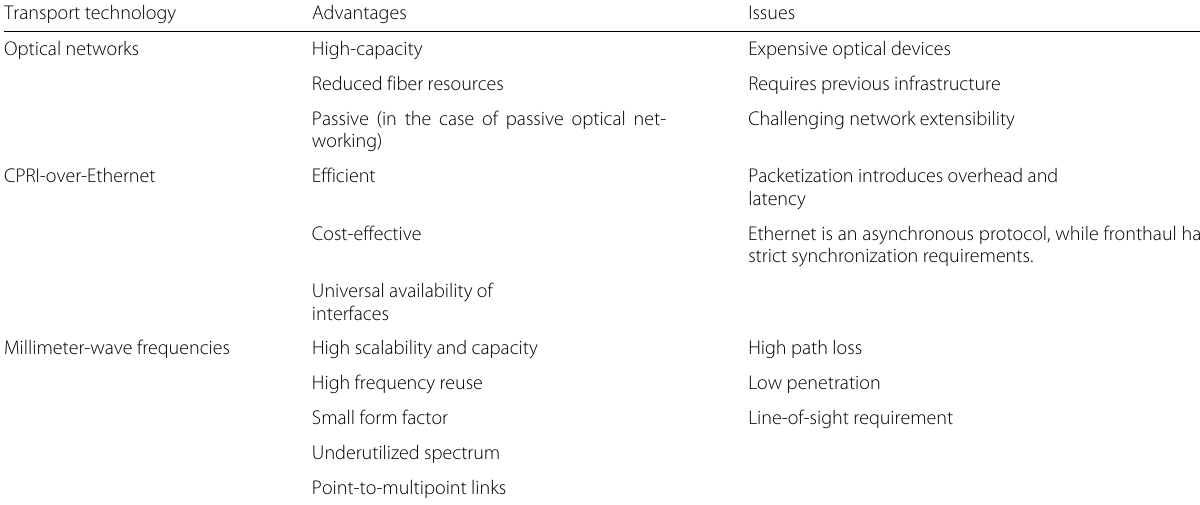
Table 3 Transport technologies for fronthaul Transport